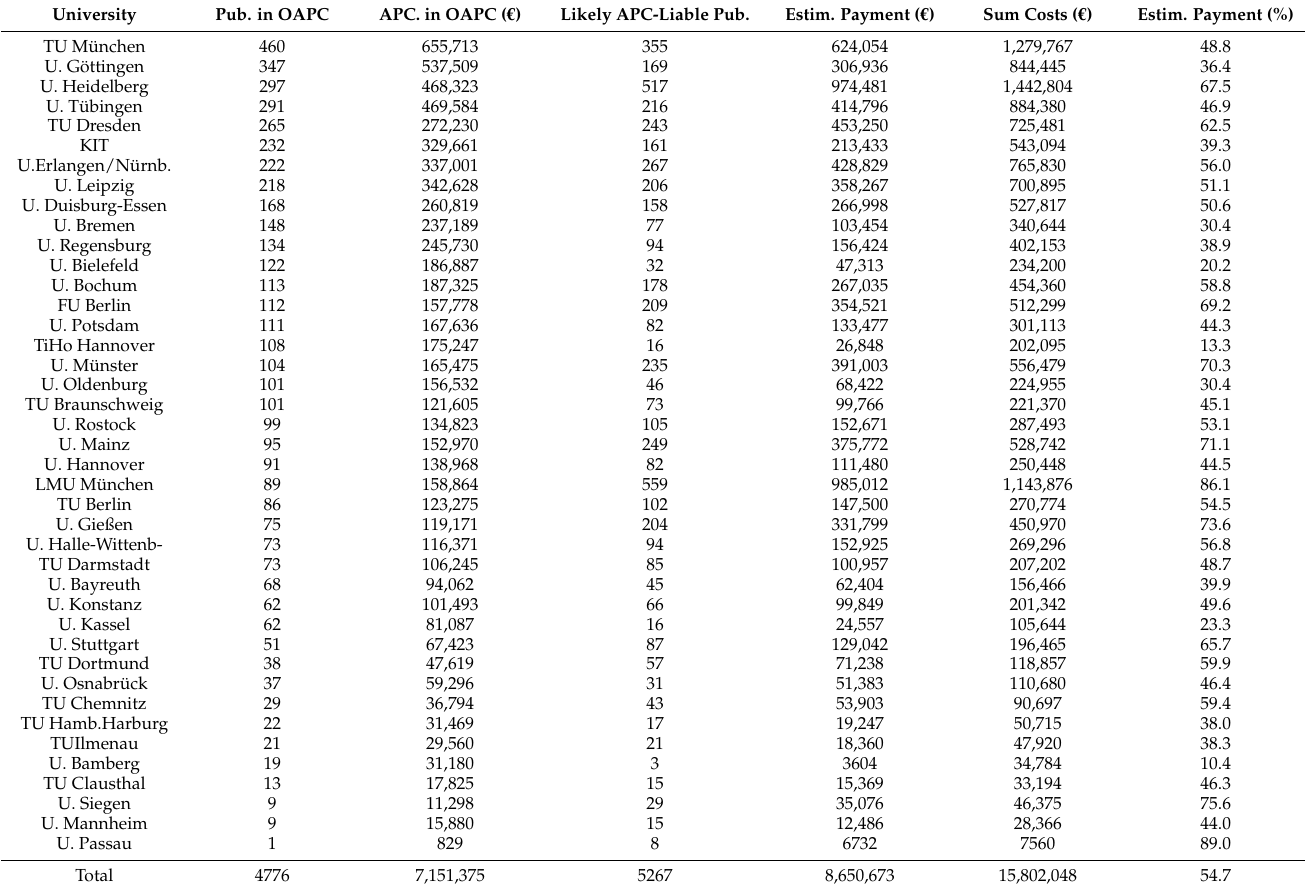
Table 1. OpenAPC universities, publications covered by OpenAPC and likely APC-liable publications in 2019. University Pub. in